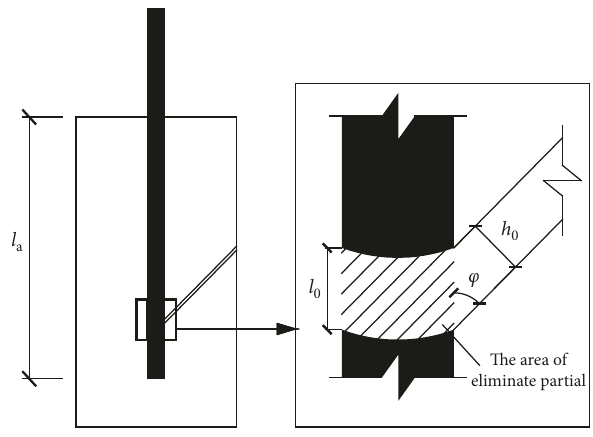
Figure 8: Schematic diagram of the calculating